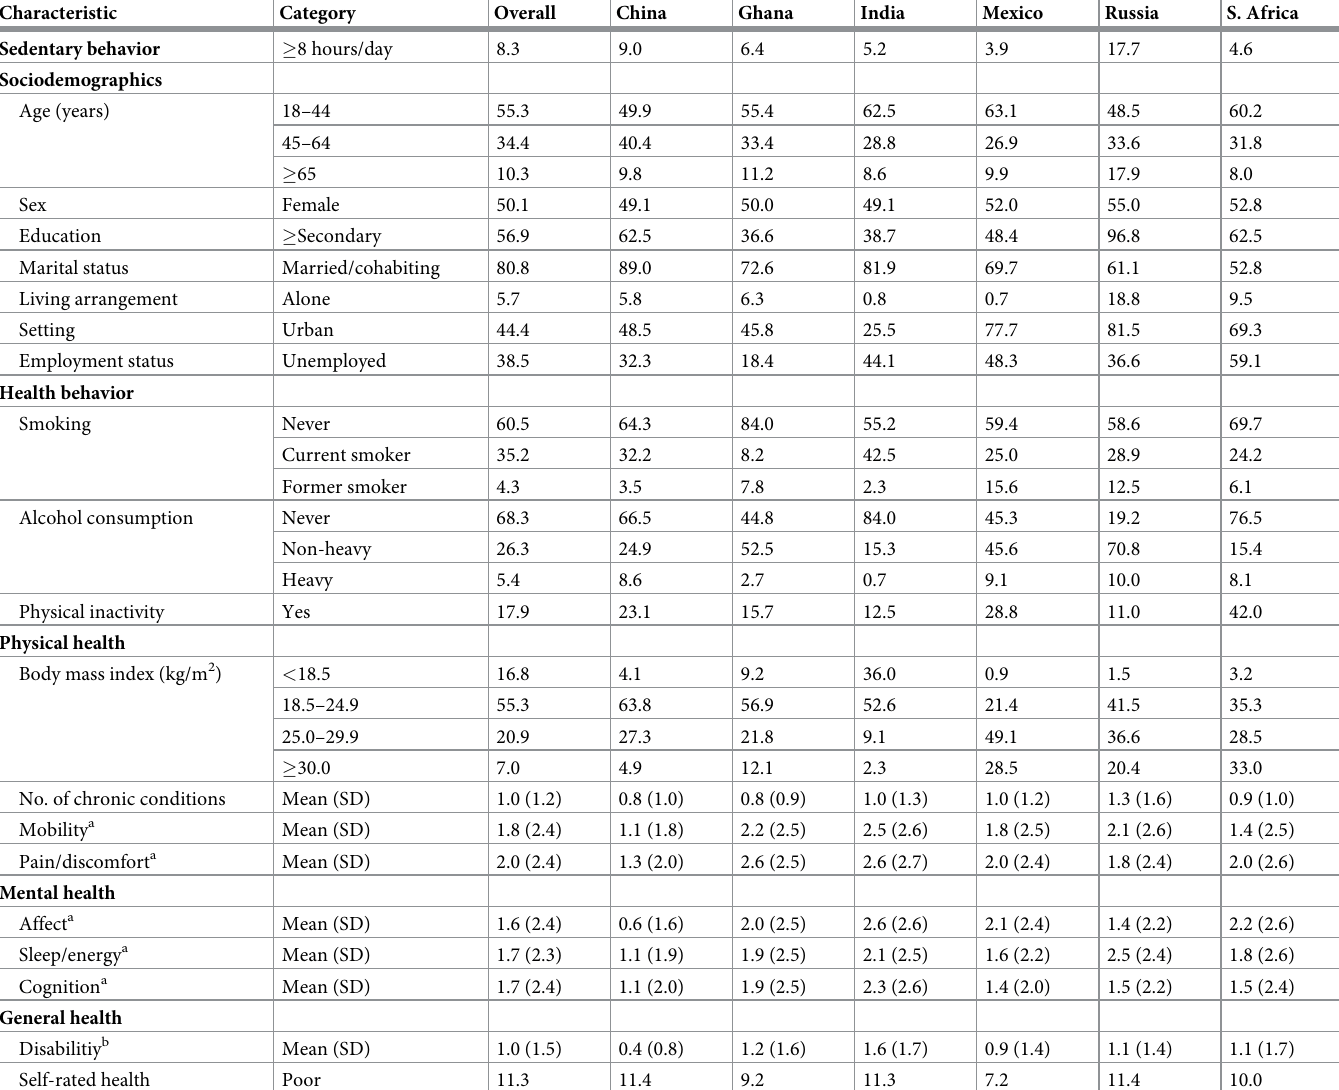
Table 1. Sample characteristics (overall and by